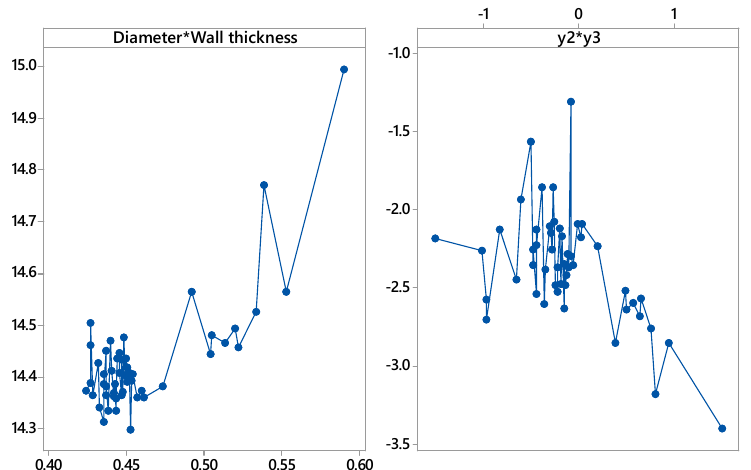
Figure 8. Scatter diagram of diameter and wall thickness and their corresponding transformed data ( y 2 and y 3 ).